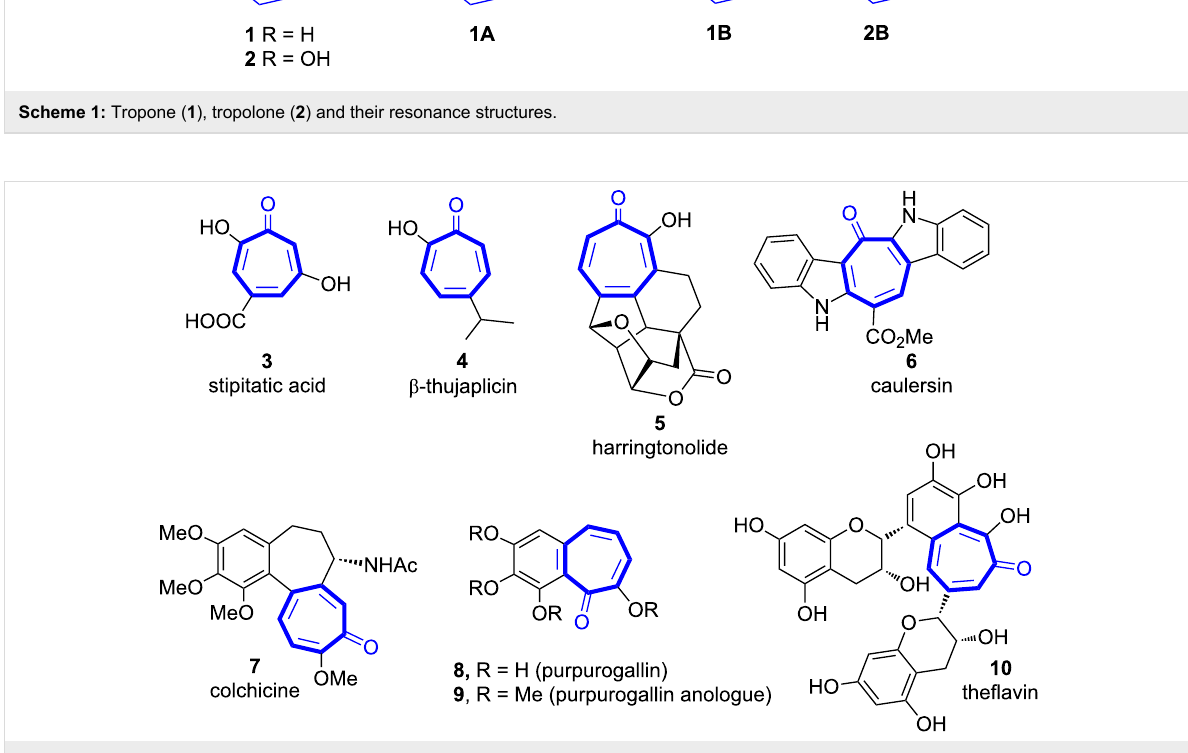
Figure 1: Natural products containing a tropone nucleus.